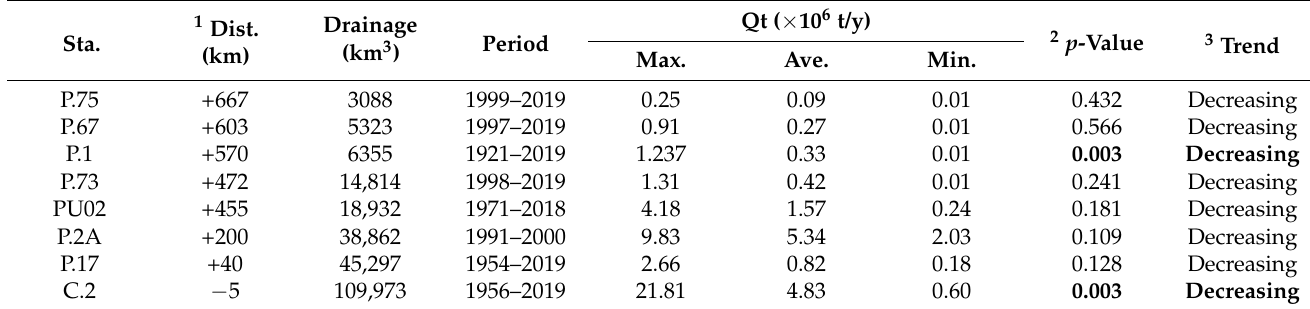
1 Distance from the Ping River outlet: + sign is the distance from the outlet toward upstream, − sign is the distance from the outlet toward downstream; 2 p -value and 3 Trend refer to Mann-Kendall test and the significant trend is marked as the